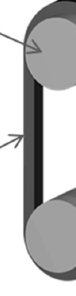
Figure 1. Schematic representation of a pin-loaded